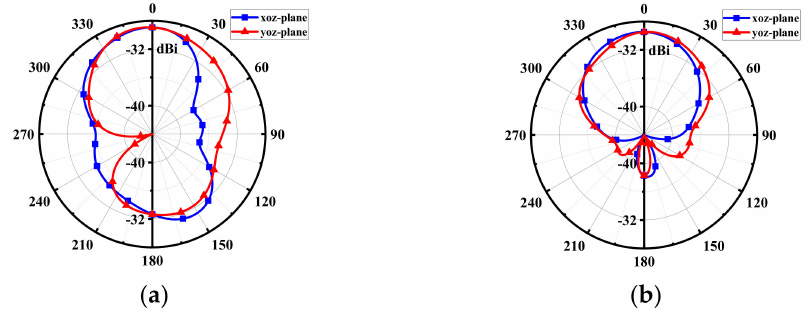
Figure 5. Simulated radiation patterns at ( a ) 915 MHz and ( b ) 2.45